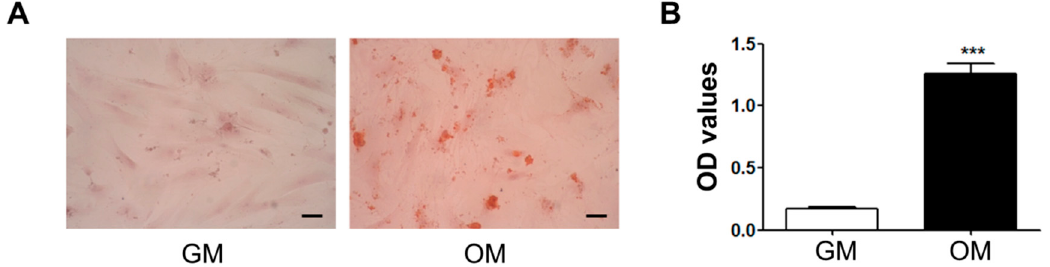
Figure 1. Cont . Figure 1.